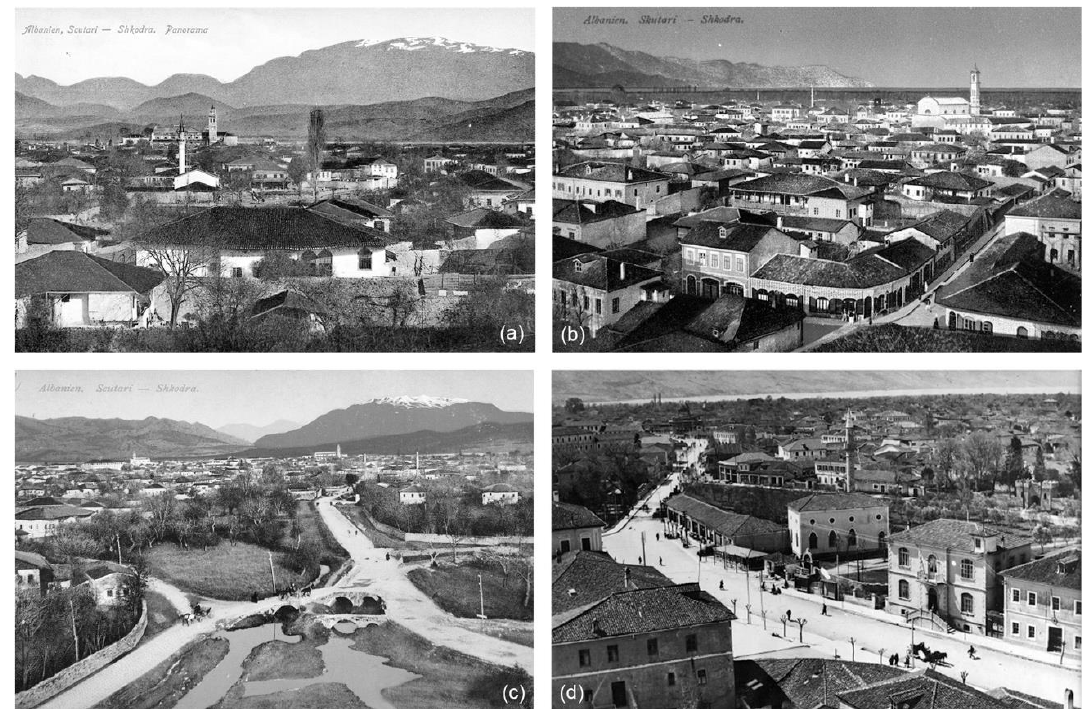
Figure 5 New part of Shkodër circa 1917: a) traditional houses with large gardens in Muslim quarters; b) densely clustered traditional houses in Catholic quarters; c) marshes separating the southern edge of the new city from the Bazaar; d) Great Rd. in the new city